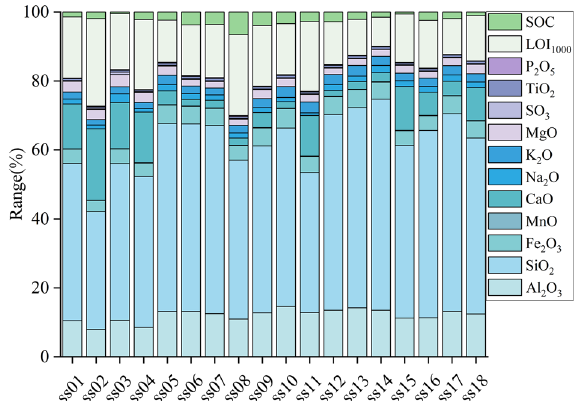
Figure 2. Whole-rock composition results of each sampling point in in the tourist area of Sayram Lake.